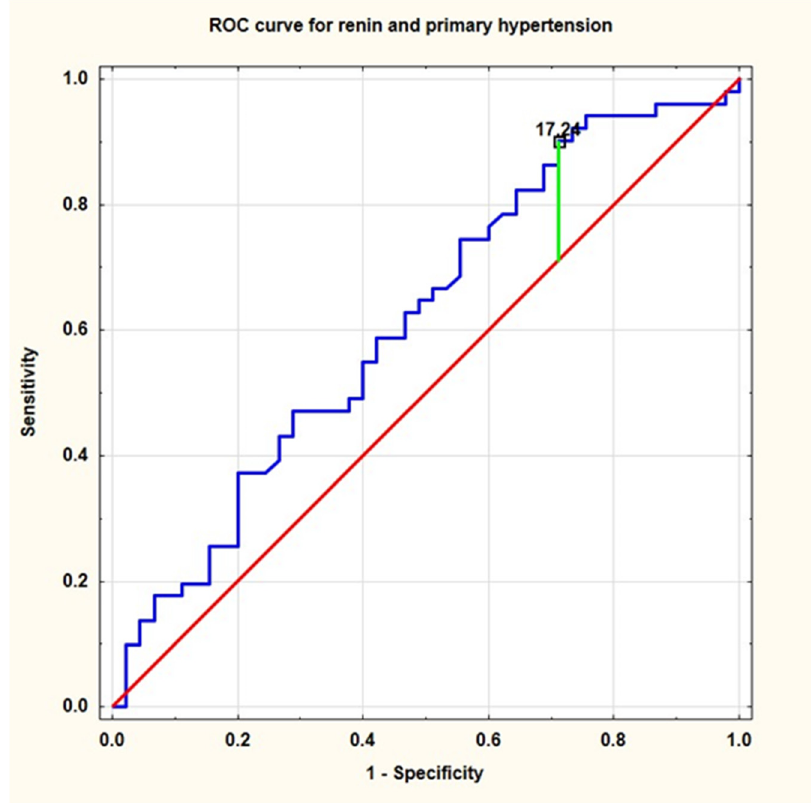
Figure 2. Receiver operating characteristic (ROC) curve for active renin concentration and the presence of primary hypertension (ROC—receiver operating characteristics).